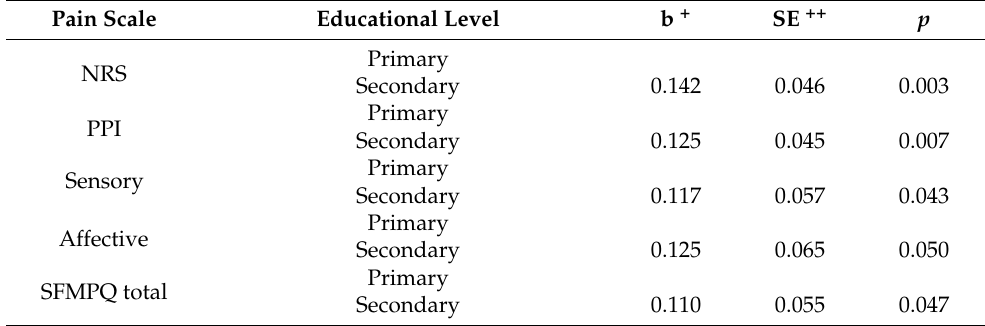
Table 5. Correlations between all pain scales with educational level of participants. Pain